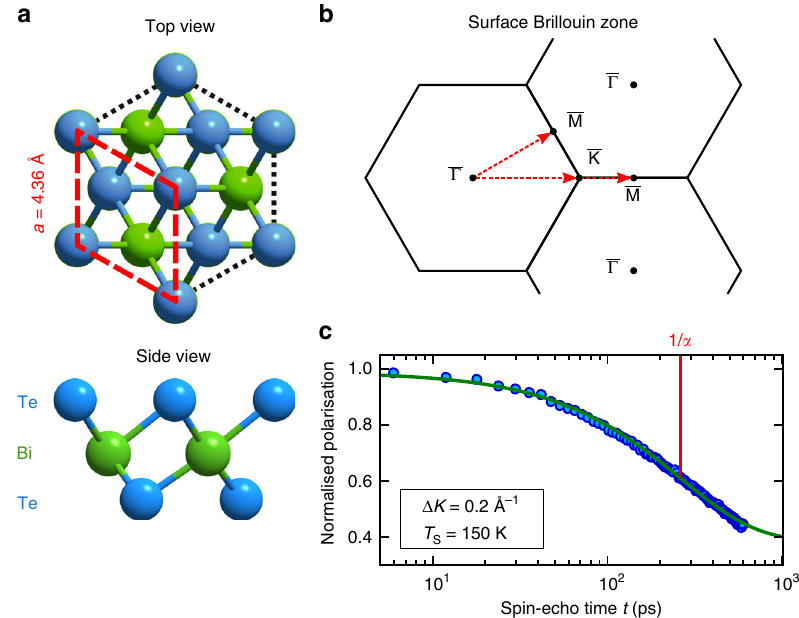
Fig. 1 Bi 2 Te 3 structure and dynamics measurements from the lineshape broadening. a Top and side view of the (111) surface of Bi 2 Te 3 . The surface layer is terminated by a Te layer and the red rhombus highlights the hexagonal surface unit cell. b Surface Brillouin zone with the corresponding scanning directions. c A typical intermediate scattering function (ISF) showing the normalised polarisation versus spin-echo time t . The measured data ( fi lled circles) is fi tted with a single exponential decay ((1), solid green line) characterised by the dephasing rate α . The logarithmic time axis shows that a single exponential provides a good description of the experimental